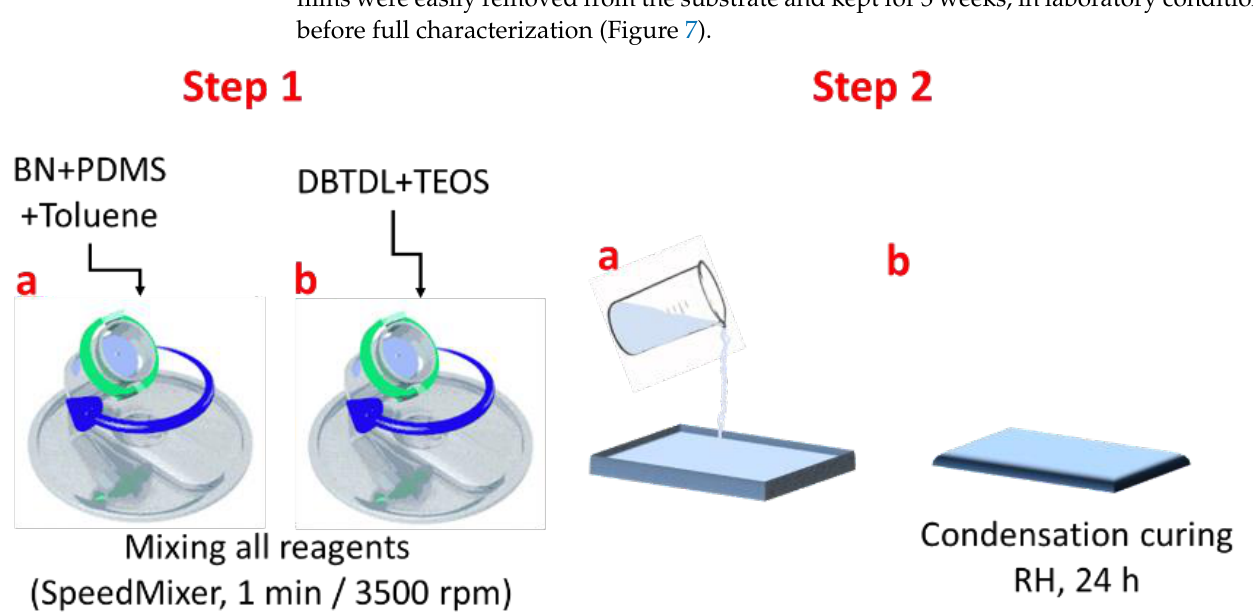
Figure 7. Manufacturing steps for obtaining silicone-based composites with BN.